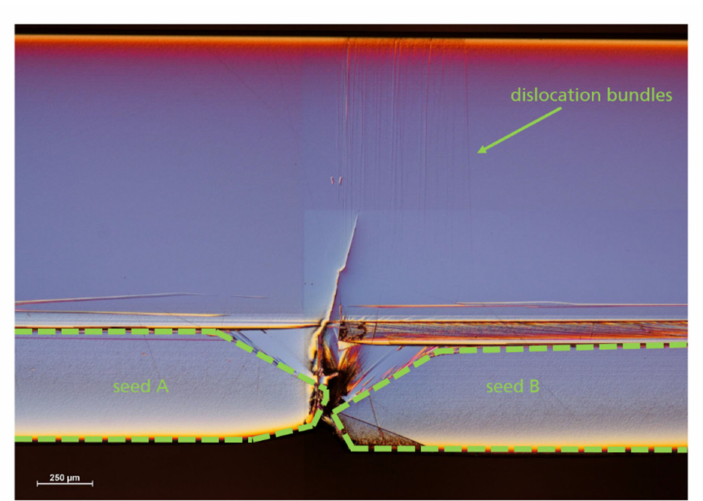
Figure A1. Light microscope image of a tiling seam of a similar Am-GaN wafer as the wafers investigated in this study. The image is a cross-section after photoelectrochemical etching. The edges of the two seed crystals A and B for area enlargement were marked with dashed green lines. Above the seam, one can see the dislocation bundles running in the